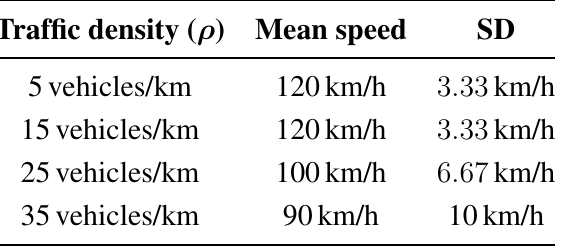
Table 6. Scenario settings for testing the store-carry-forward